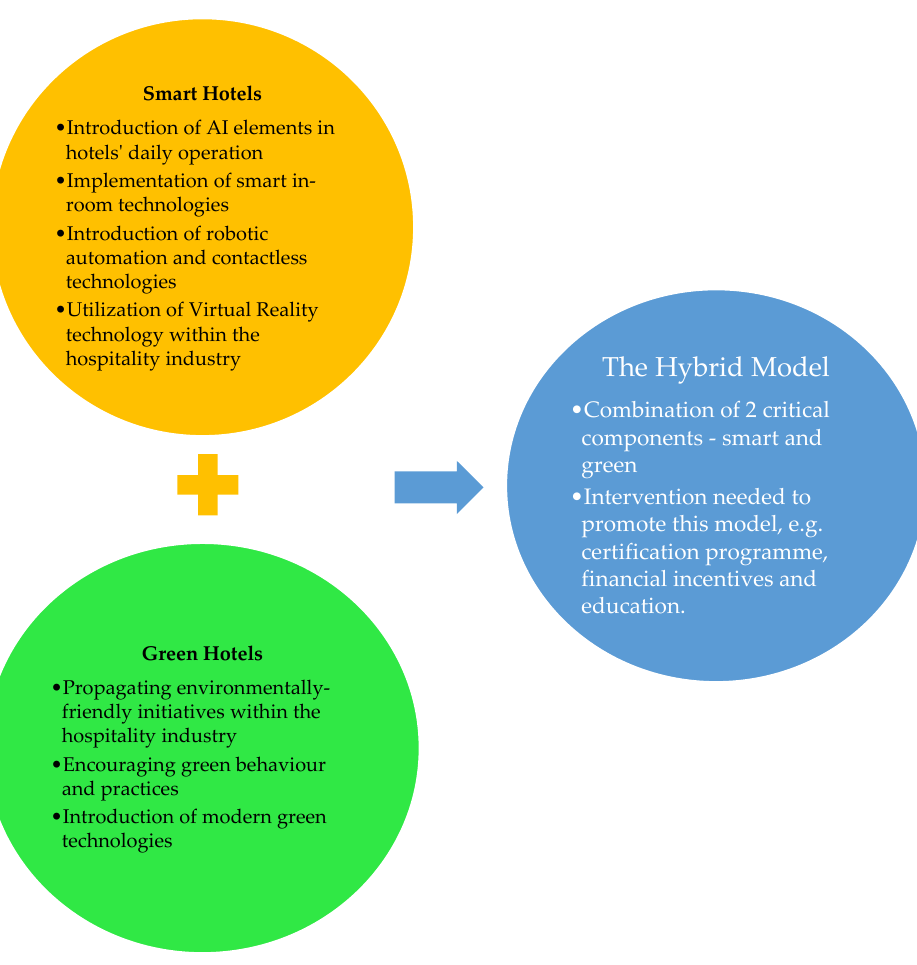
Figure 1. Exploring the Hybrid Model.